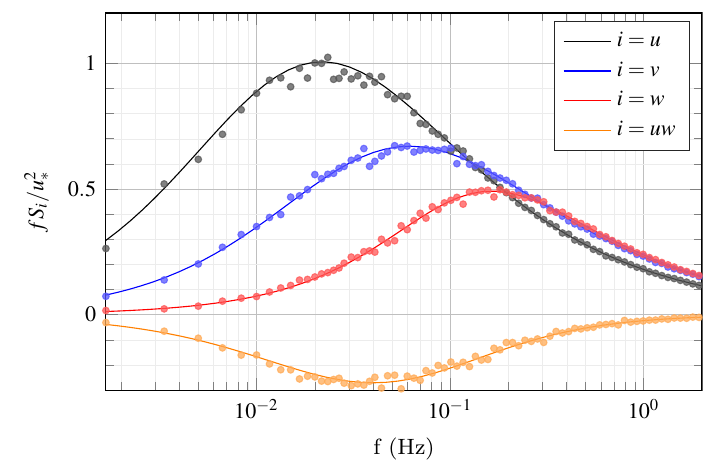
Figure 9. Target co-coherence (solid lines) and estimated one (markers) between elements 1 and 2 ( top panels ), elements 1 and 4 ( middle panels ) and elements 1 and 3 ( bottom panels ) of the diamond geometry.